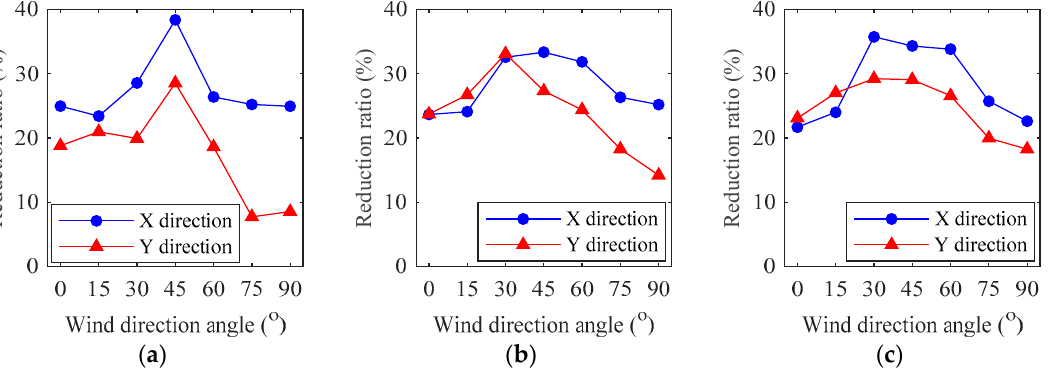
Figure 20. Variation of reduction ratio with wind direction and wind speed. ( a ) 18.5 m/s; ( b ) 22.6 m/s; ( c ) 24.7 m/s.